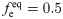
Relaxation-affected extracellular signal fraction as a function of ktm for different values of ΔR2tE.Solid lines represent the case when diffusion filter gradients are applied in the first PGSTE block, while dashed lines are for the case without the filter gradients (see Fig 3). The results for different values of ΔR2tE are labeled on the right ranging from −5 to +5 and color coded from blue to red for negative values and from red to green for positive values. In all cases, fe0 = 0.05 and feeq=0.5.